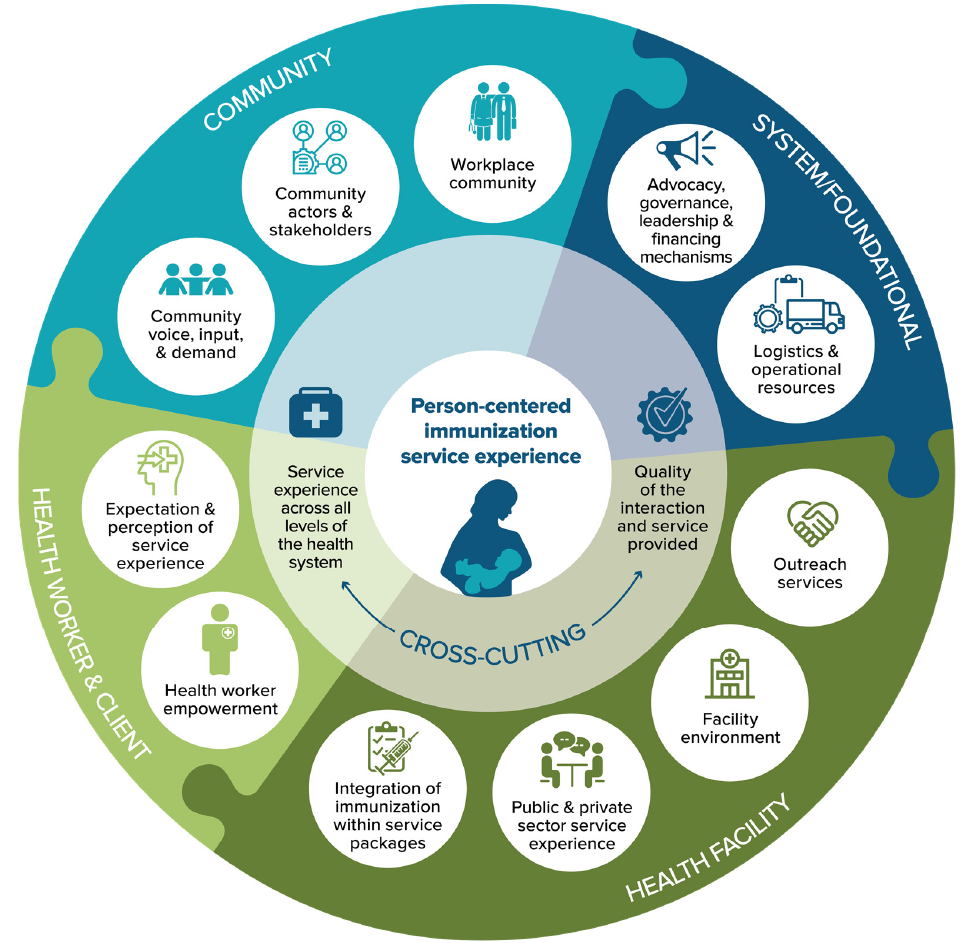
Figure 2. Person-centered immunization service experience graphic.